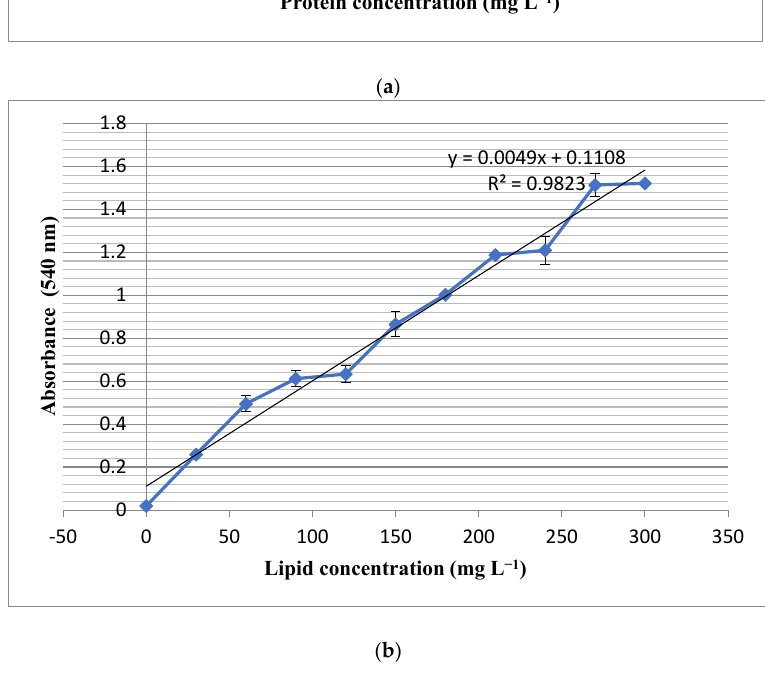
y = 0.0036x + 0.1655